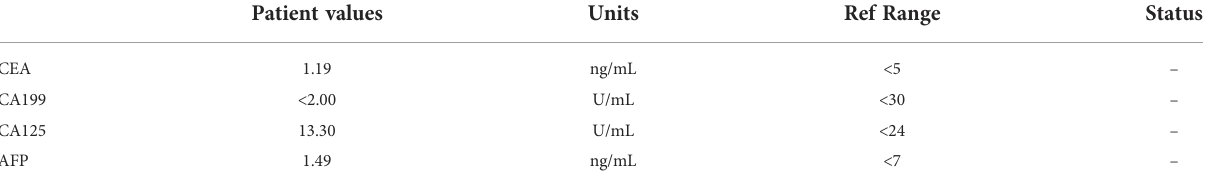
TABLE 1 Measurement of plasma tumor markers on April 22,